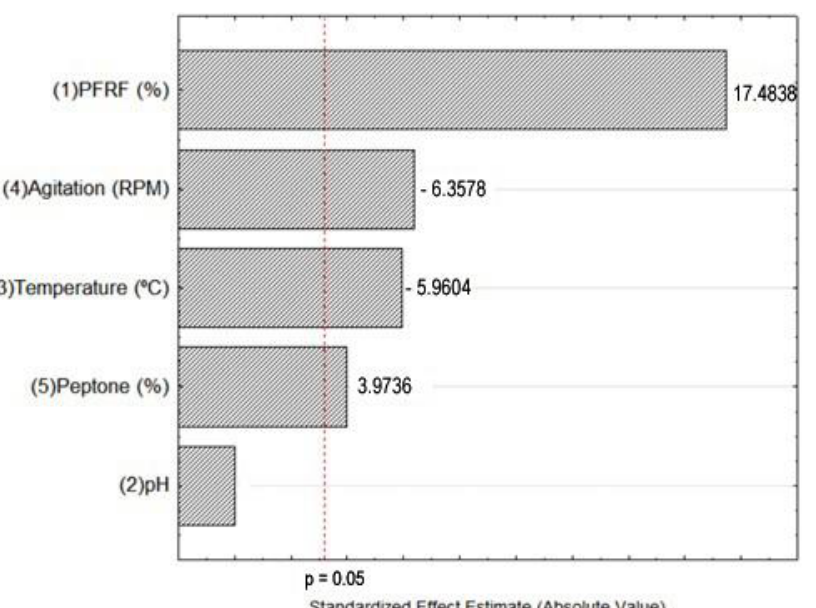
Figure 1. Pareto ’ s chart for the fractional factorial experimental design. Figure 1. Pareto’s chart for the fractional factorial experimental